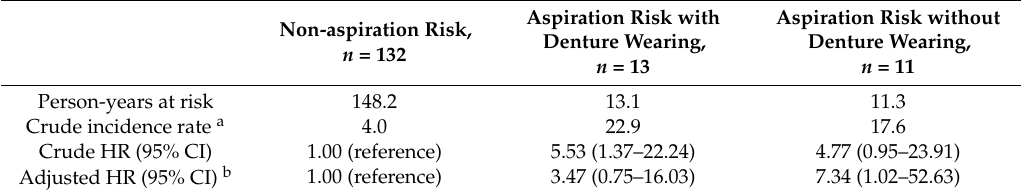
Table 3. Relationship between denture wearing and incident pneumonia stratified according to aspiration